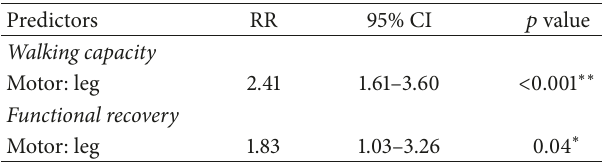
Table4:Independentpredictorsofwalkingandfunctionalrecovery of left-sided hemispheric stroke within 6 months after stroke using multivariable analysis with the generalized linear